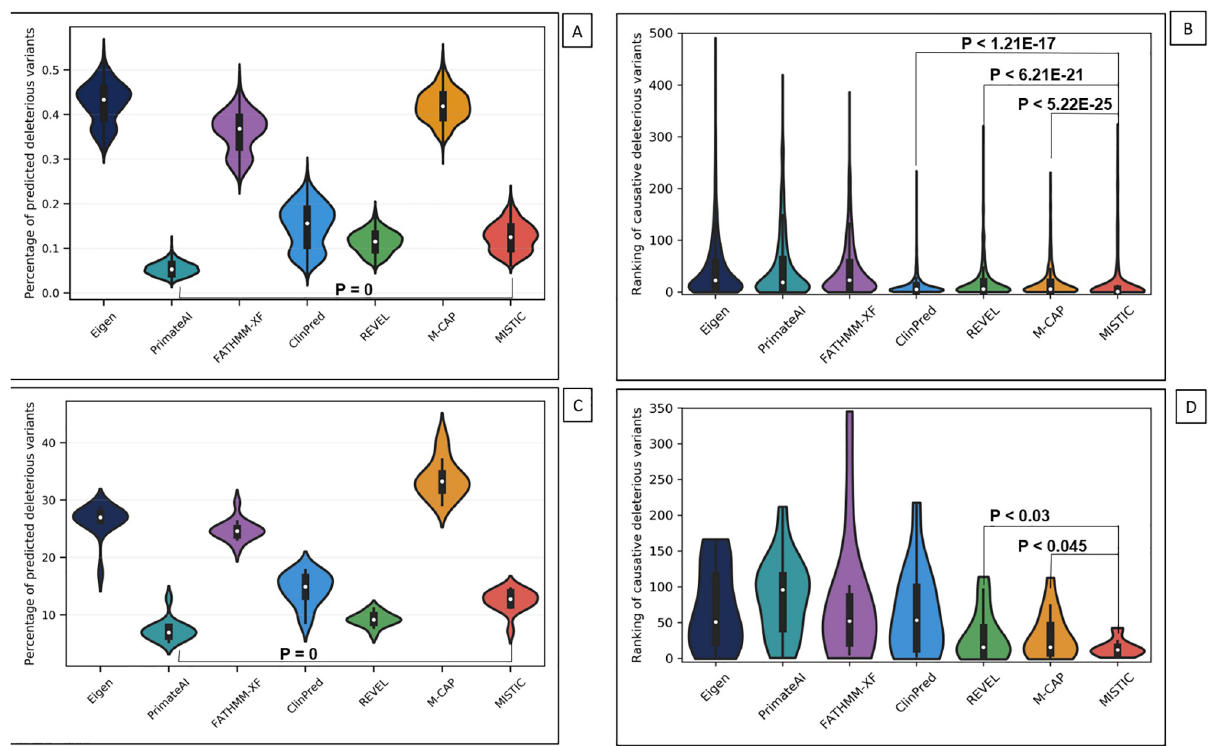
Fig 3. Evaluation of the different missense prediction tools using simulated and real disease exomes. A–Distribution of the percentage of predicted deleterious variants in the simulated disease exomes. B–Ranking of the “causative” deleterious variants introduced in simulated disease exomes. C– Distribution of the percentage of predicted deleterious variants on the exomes of the MyoCapture project. D–Ranking of the causative deleterious variants identified in real congenital myopathy exomes from the MyoCapture project.